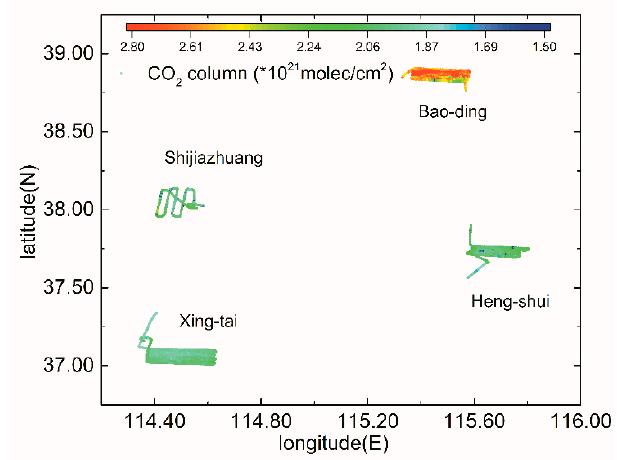
Figure 15. Regional CO 2 distribution of the four cities (Xing-tai, Baoding, Henshui, and Shijiazhuang) observed at 3 km by Air-IRSS.